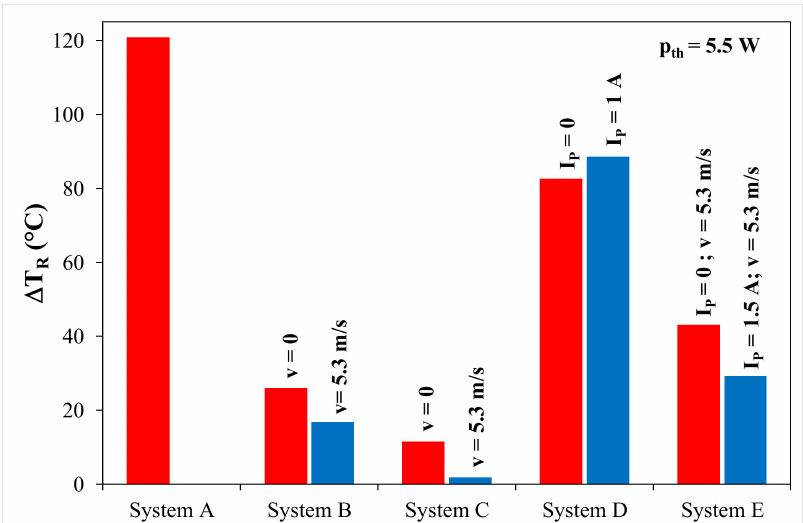
Figure 22. Values of an excess of the temperature of the considered resistor over the ambient temperature for the fixed value of the dissipated power for all the investigated cooling